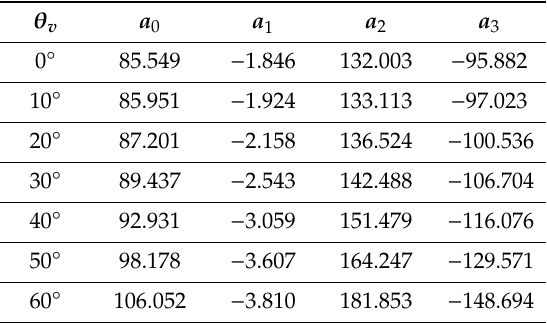
Table 3. Coe ffi cients of the TOA-LIN model with VZA = 0 ◦ –60 ◦ .